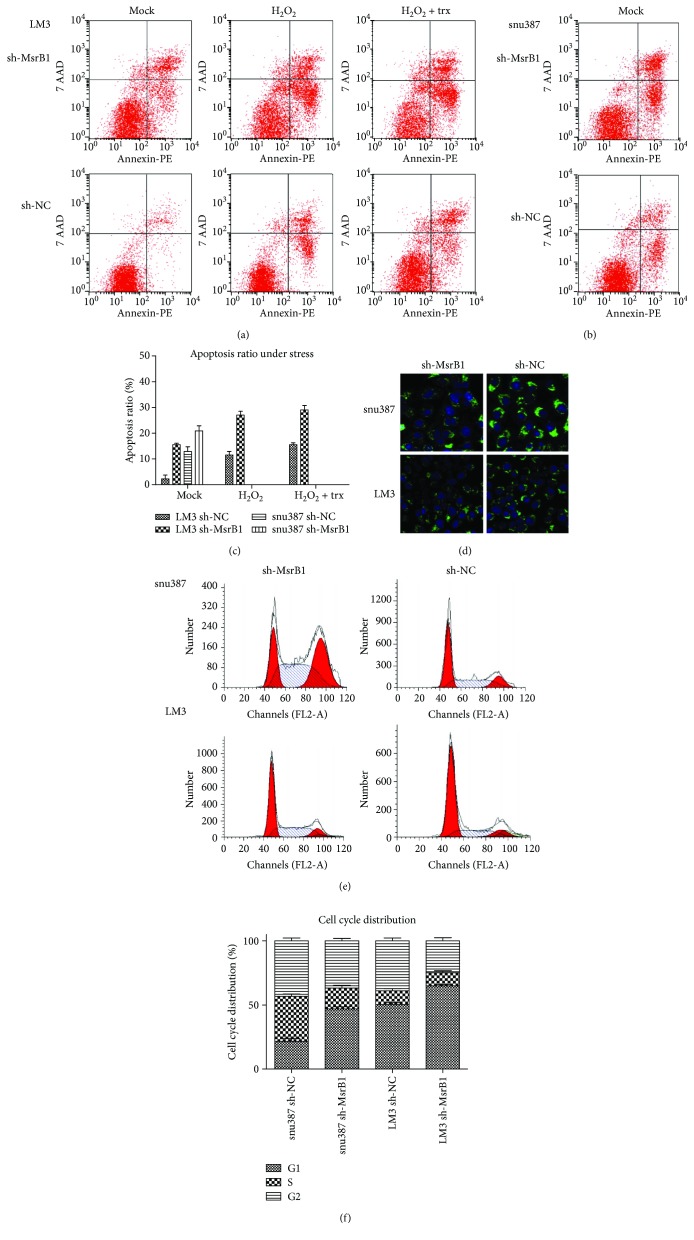
MsrB1 induced apoptosis and cell cycle arrest of HCC cells. (a, c) Knockdown of MsrB1 enhances H2O2/trx-induced apoptosis of LM3 cells. (b, c) Knockdown of MsrB1 enhances apoptosis of snu387 cells. (d) Mitochondrial integrity completely disappeared in HCC cells due to MsrB1 knockdown, resulting in the fragmentation of some mitochondria. (e, f) Knockdown of MsrB1 induced S/G2 phase arrest and G1 phase decrease.